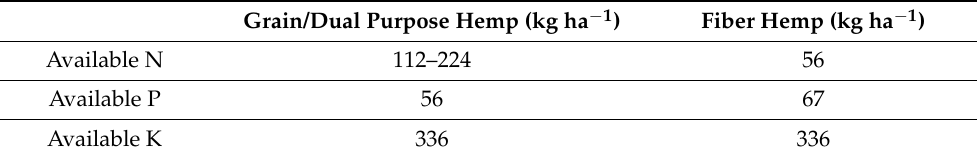
Table 2. Macronutrient requirements for industrial hemp (adapted from Kostuik and Williams, 2019)